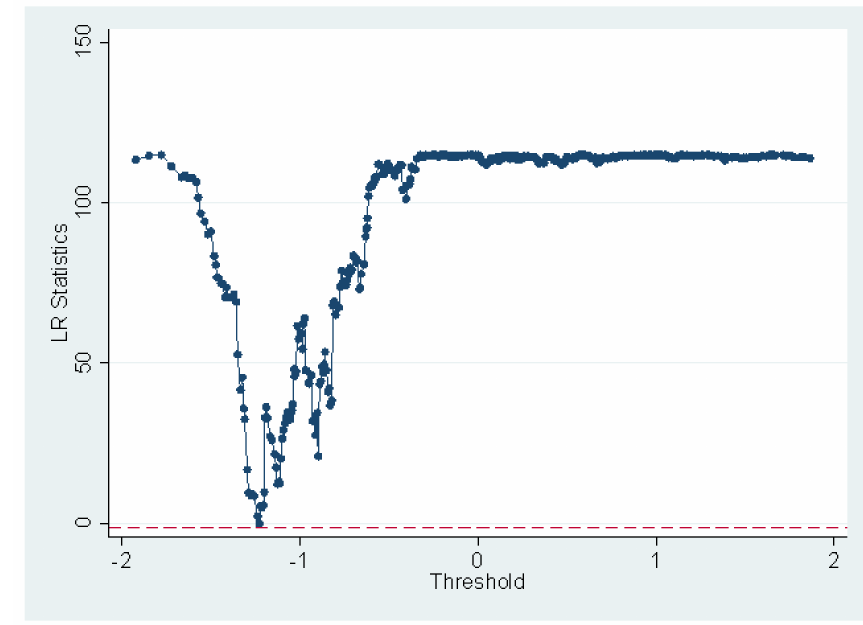
Figure 5. Confidence interval structure for a single-threshold